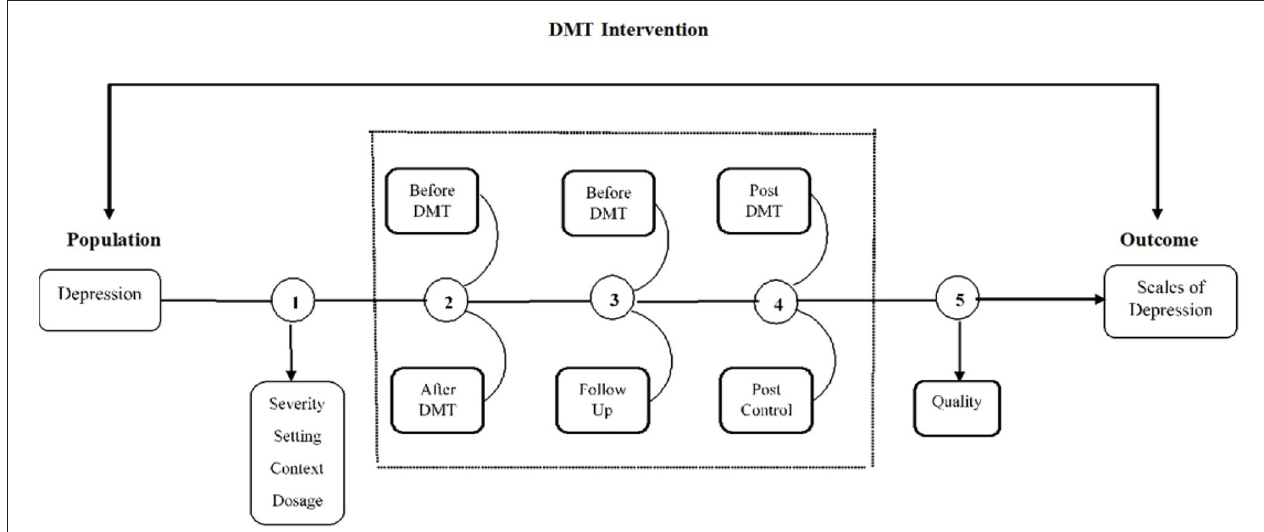
FIGURE 1 | Analytic